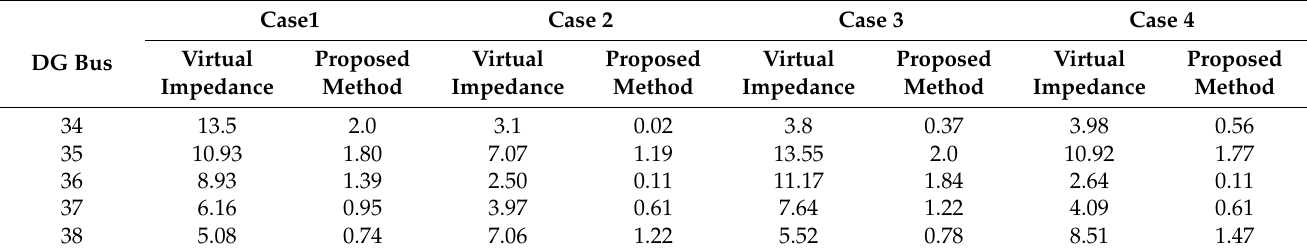
Table 3. DG buses’ estimated short circuit current during the fault for two